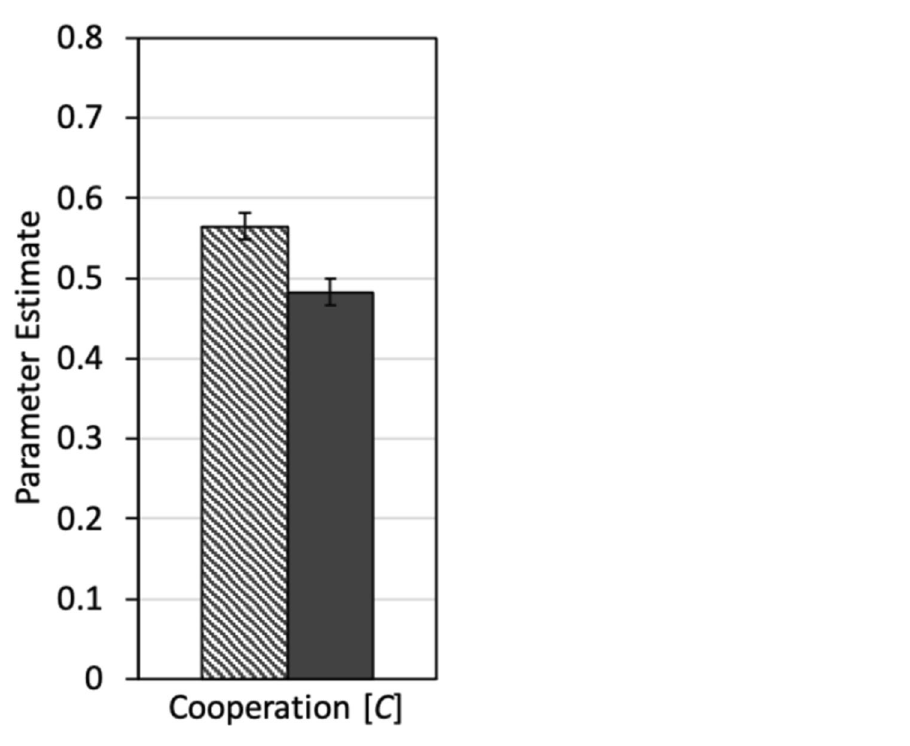
Figure 6. Parameter estimates for parameter C reflecting the probability that a participant decided to cooperate as a function of framing (moral, neutral). The error bars represent the standard errors.